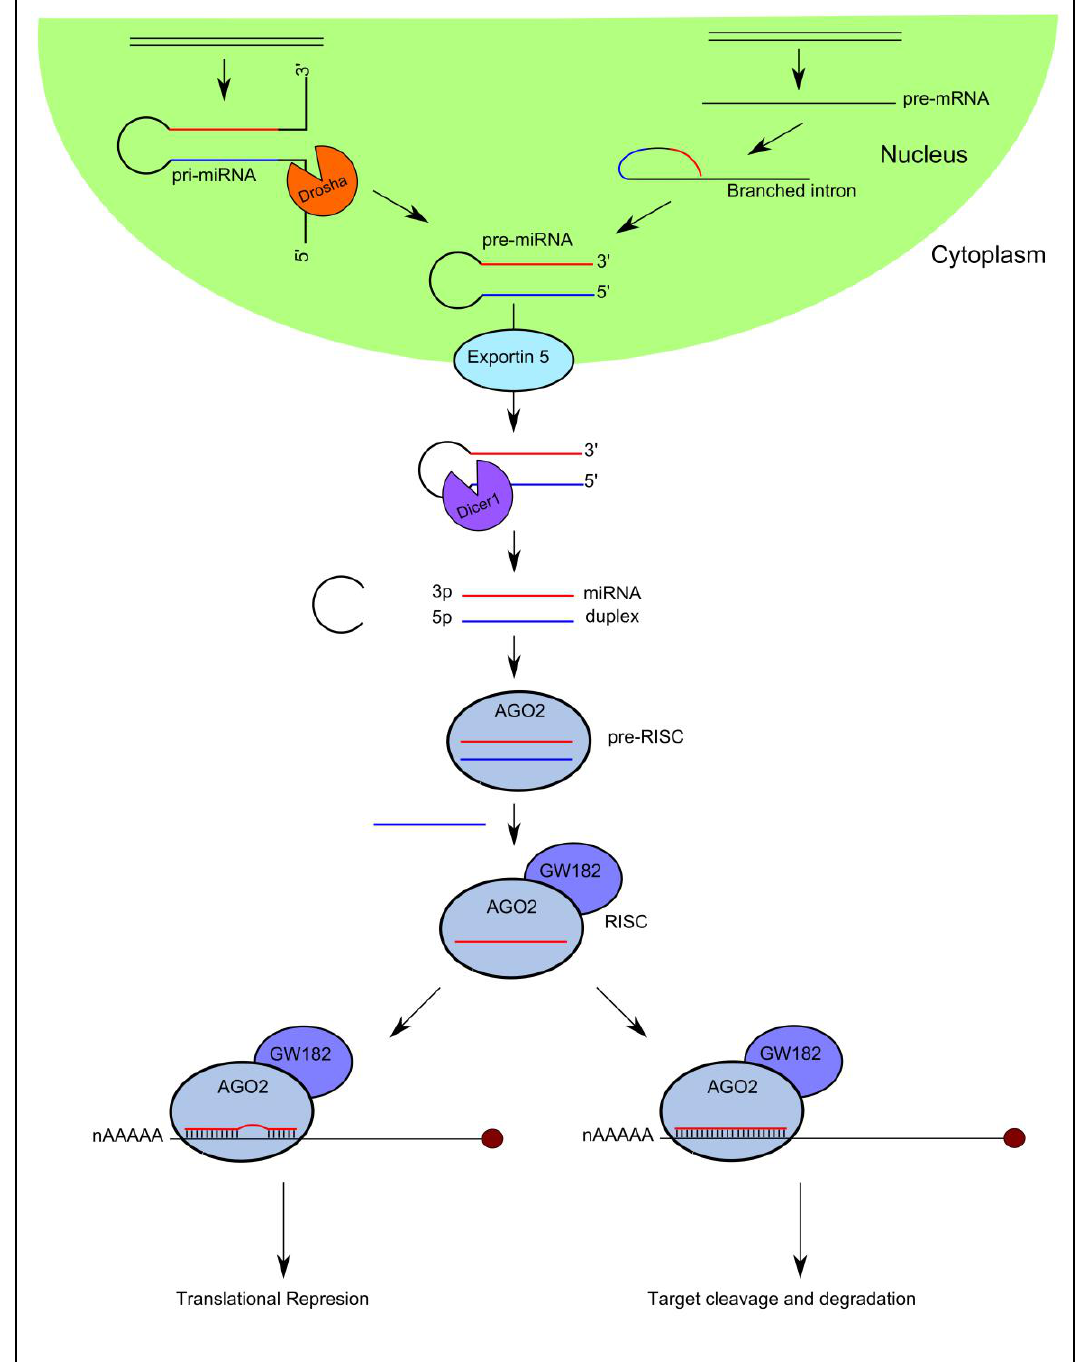
Figure 1. MicroRNA (miRNA) biogenesis and function. Precursor molecules termed primary miRNAs (pri-miRNAs) are transcribed from their cognate genes in the nucleus. Pri-miRNAs are cleaved by Drosha and DGCR8, to generate a 60–70 nucleotide precursor miRNAs (pre-miRNAs). Pre-miRNAs are transported to the cytoplasm by Exportin-5 in a Ran-GTP dependent manner, where it they are cleaved by Dicer generating a small miRNA duplex. TAR-RNA-binding protein TRBP interacts with Dicer and the bound double strand RNA (dsRNA) duplex, and recruits AGO2 to nucleate RNA-induced silencing complex (RISC). The guide strand is incorporated into RISC, while the complementary strand is excluded. The mature miRNA then guides RISC-induced messenger RNA (mRNA) down-regulation through translational repression or mRNA cleavage depending on the level of sequence complementarity between the miRNA and target mRNA.